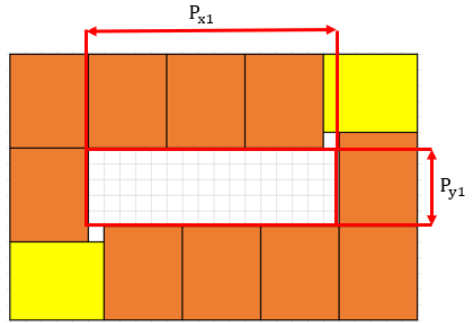
Figure 13. The area after calculation when Block 1 and Block 3 are overlapped. Figure 14. The area after calculation when Block 2 and Block 4 are